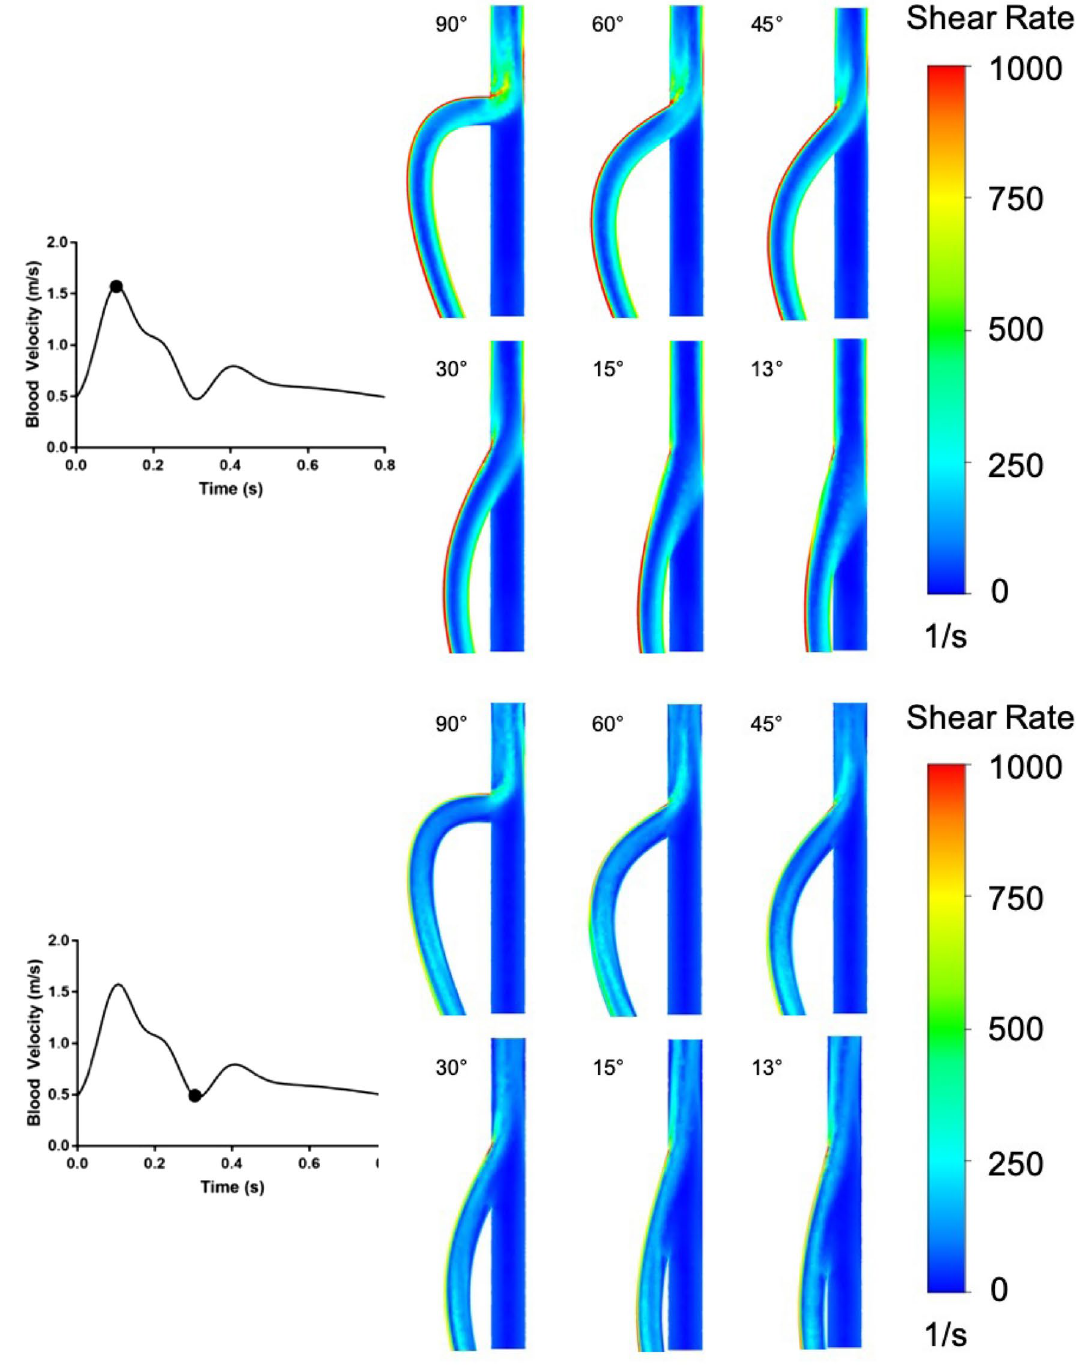
Figure 5. Cross section of anastomoses at selected times over the course of a heartbeat. Top panel: 0.1 s through the heart beat, which was shown to be a time point of excessive high shear rate for all graft-to-vein anastomosis angles considered. Bottom panel: 0.3 s through the heartbeat, which was shown to be a time point of excessive low shear rate for all graft-to-vein anastomosis angles considered. Contours represent shear rates over the entire wall area, both distal and proximal to the